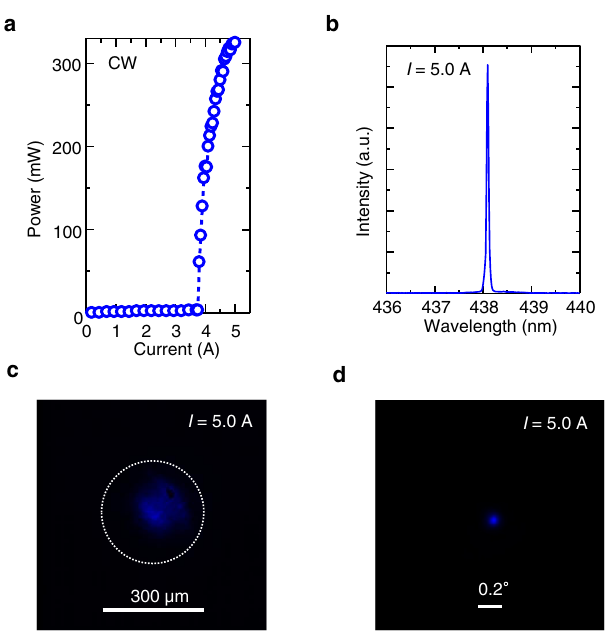
Fig. 6 Lasing characteristics of a GaN-based PCSEL with double-lattice photonic crystals under CW operation. a Output power as a function of current under CW operation at 20 °C. b Emission spectrum under CW operation under an injection current of 5.0 A. The white dashed line indicates the current injection area. c Measured near- fi eld pattern under CW operation at an injection current of 5.0 A. d Measured far- fi eld pattern under CW operation at an injection current of 5.0